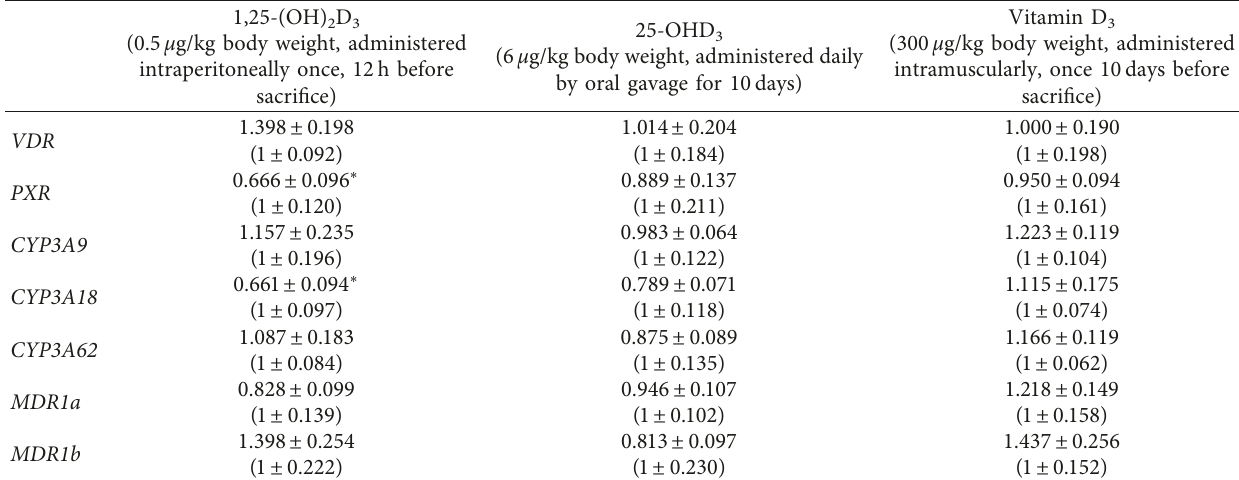
Table 6: RNA expression in the liver of rats treated with different vitamin D metabolites normalized to β -actin.